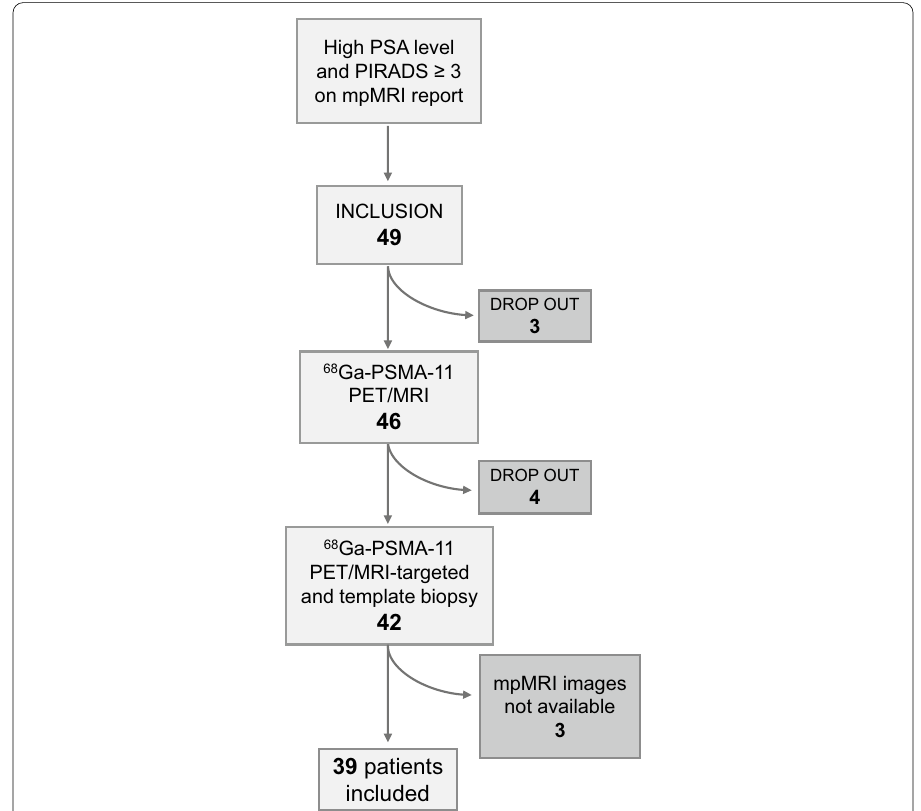
Fig. 1 Patient selection. After signing the informed consent, three patients refused PSMA PET/MRI and other four patients gave up participation before the biopsy. mpMRI images from three patients were not